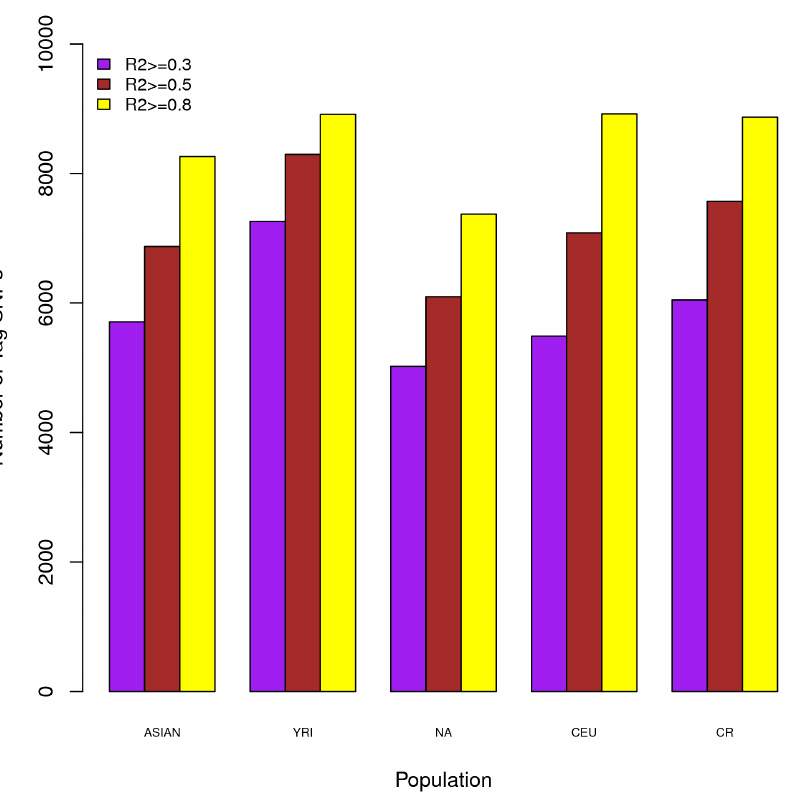
Figure 8. LD comparison among the CR rural population and its ancestral populations. Number of tag SNPs needed to cover the same gene regions was used as a measurement for the strength of LD. Populations with stronger LD would need less number of SNPs tagging the regions given certain r 2 threshold compared to populations with weaker LD.